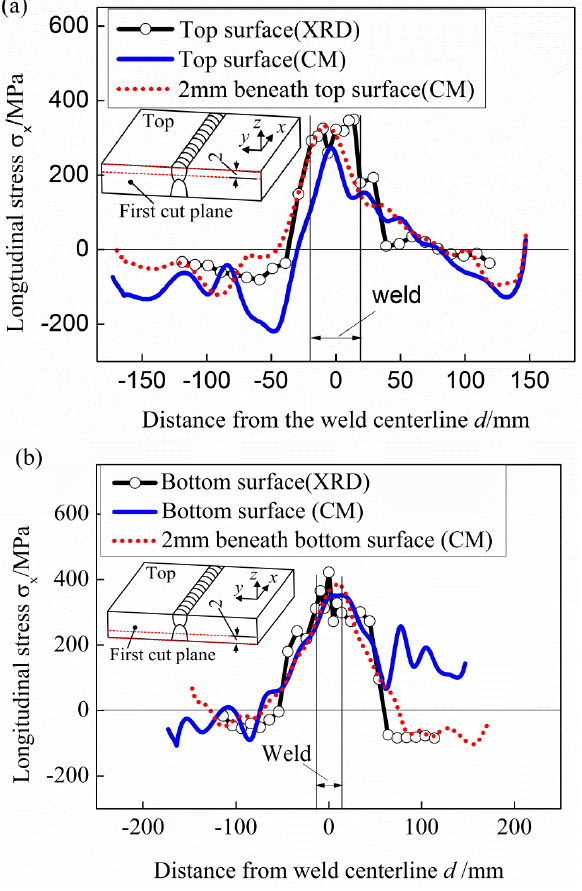
Figure 7. Comparison between the results measured by XRD and CM. ( a ) Top surface and 2 mm beneath the top; ( b ) bottom surface and 2 mm beneath the bottom surface.